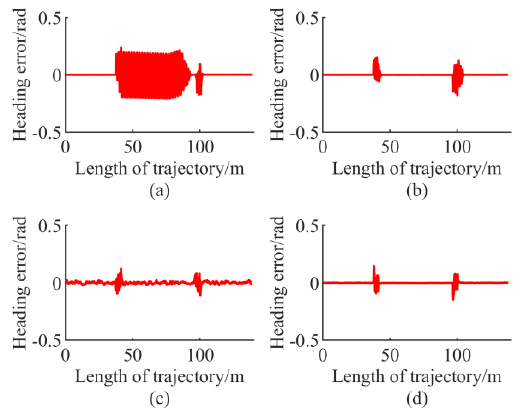
Figure 42. The displacement error of the final set of comparison. ( a ) LMPC. ( b ) LEMPC. ( c ) NMPC. ( d ) NEMPC.